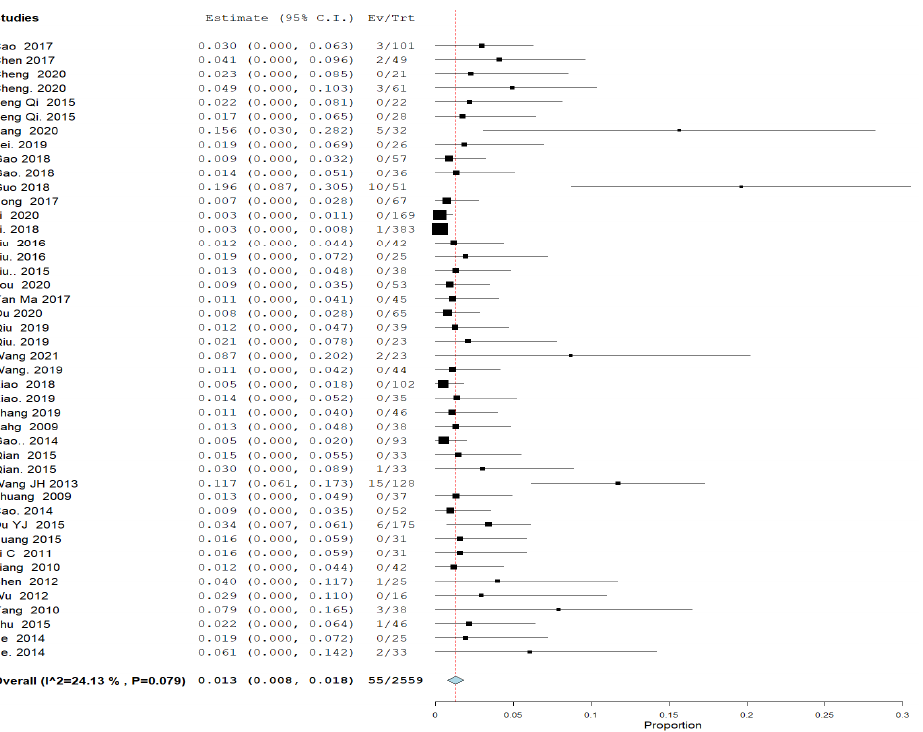
Figure 5. A forest plot of the severe complication